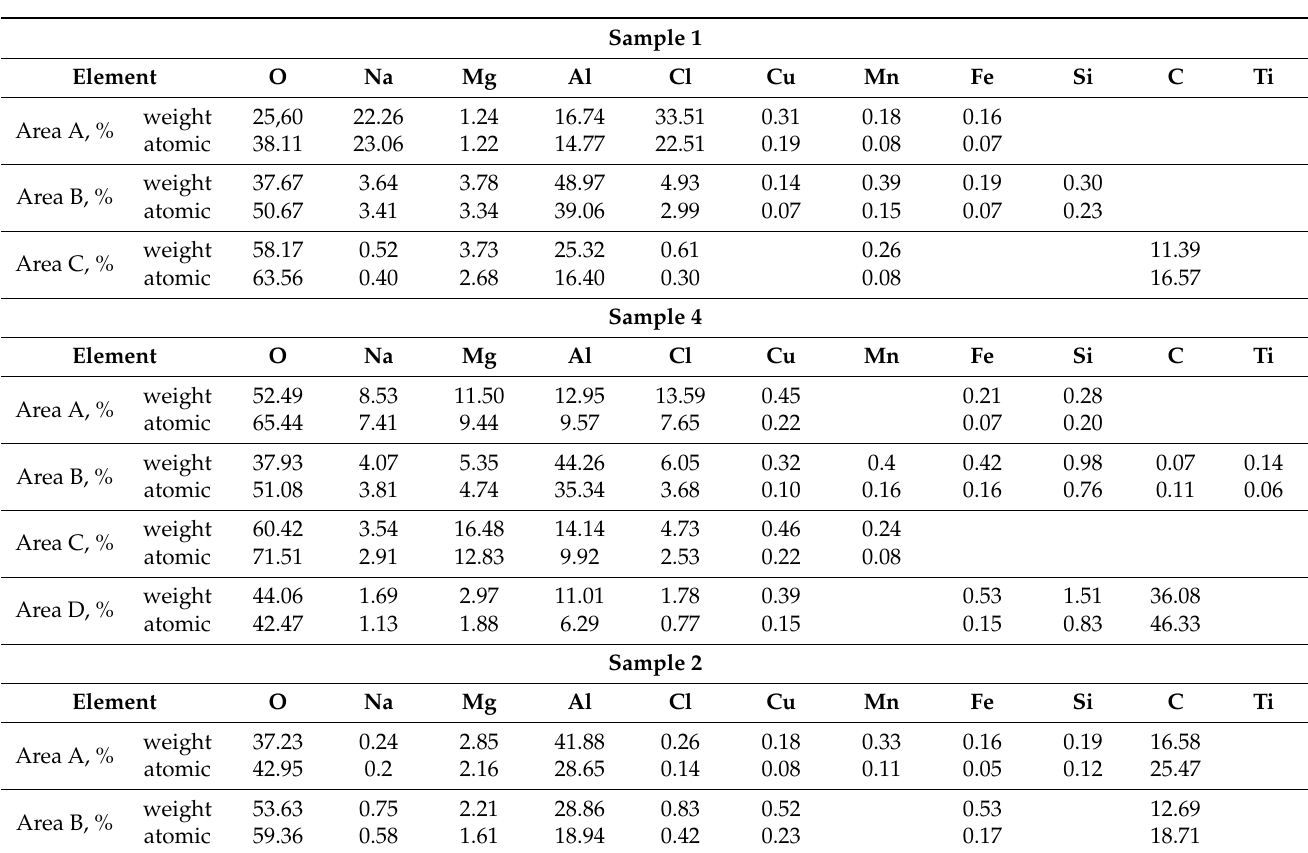
Table 3. Component composition of corrosion products (samples 1, 2 and 4 correspond to Table